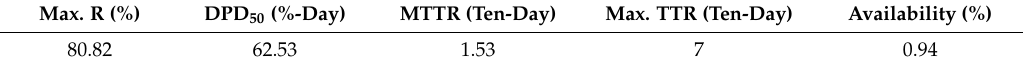
Figure 5. Water shortage ratio (R) in Changhua ( a ) and Yunlin ( b ) for agricultural water use. Table 4. Analysis of water shortage of Formosa Plastics Corporation (FPC) under baseline. Max. R (%)